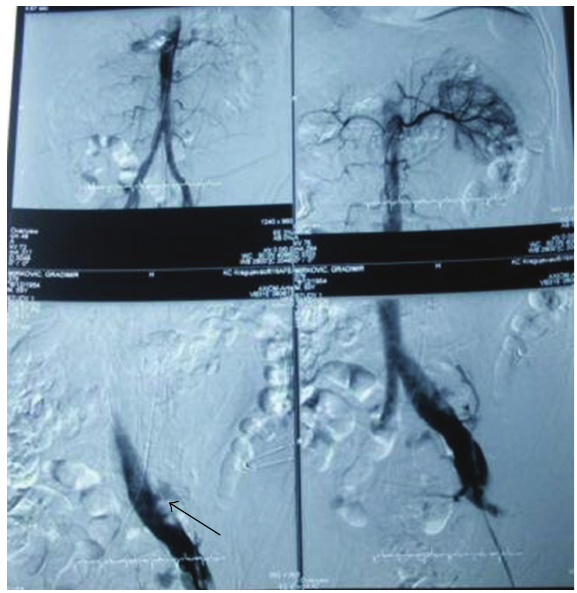
Figure 2: Extravasation of contrast (black arrow) from the iliac